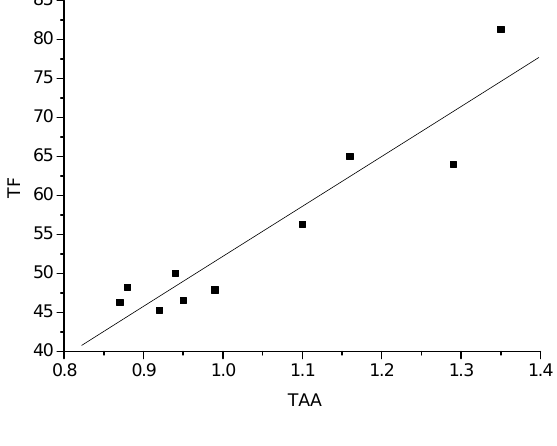
Figure 2. Correlation between total flavonoids and total antioxidant